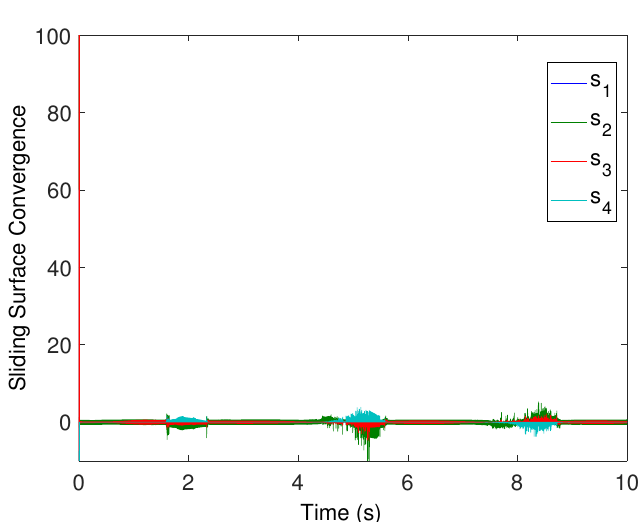
Figure 8. Control inputs’ history.